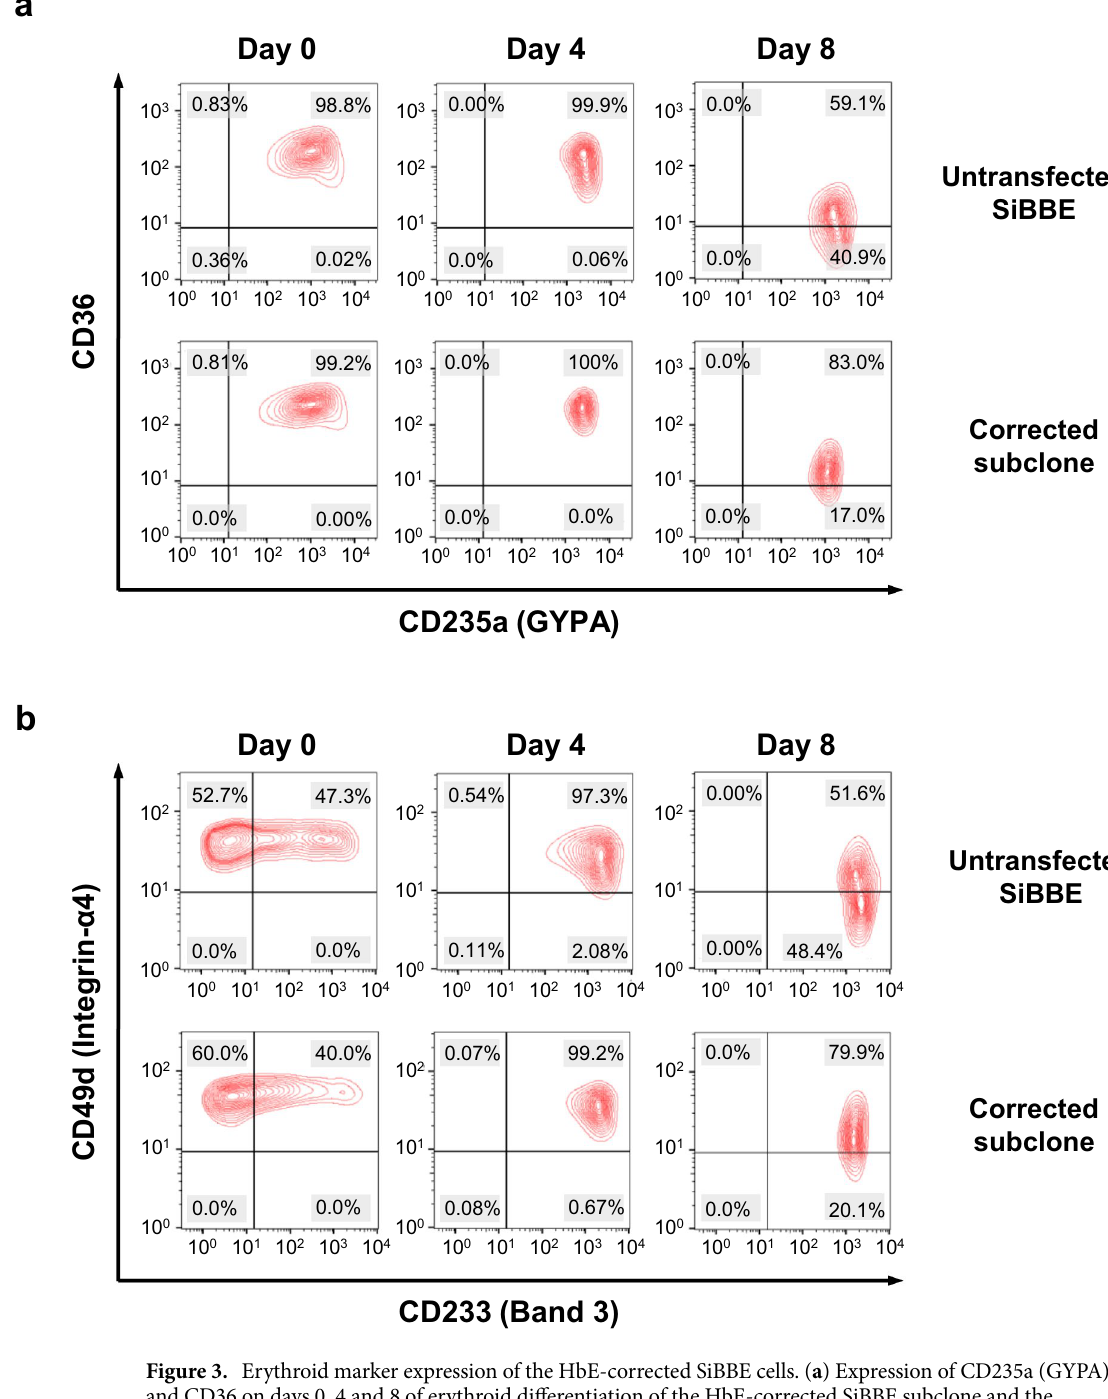
Figure 3. Erythroid marker expression of the HbE-corrected SiBBE cells. ( a ) Expression of CD235a (GYPA) and CD36 on days 0, 4 and 8 of erythroid differentiation of the HbE-corrected SiBBE subclone and the untransfected SiBBE cells as analysed by flow cytometry; representative plots of three independent cultures. ( b ) Expression of CD233 (Band3) and CD49d (integrin α4) on days 0, 4 and 8 of erythroid differentiation of the HbE-corrected SiBBE subclone and the untransfected SiBBE cells as analysed by flow cytometry; representative plots of three independent cultures. Figures were generated using the FlowJo v10 software (BD Biosciences, https:// www. flowjo. com/ solut ions/ flowjo/ downl